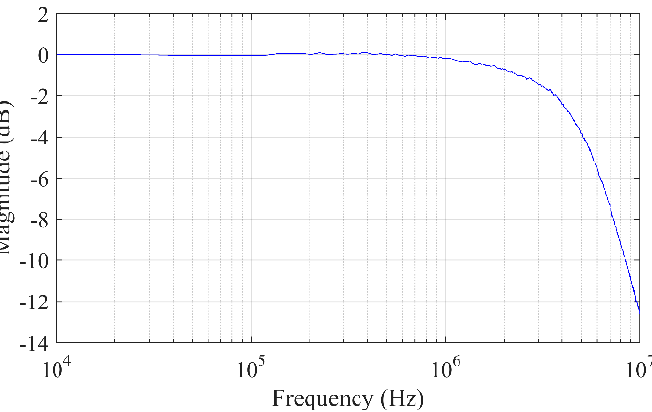
Figure 12. Measured frequency response of the proposed amplifier connected as voltage follower.